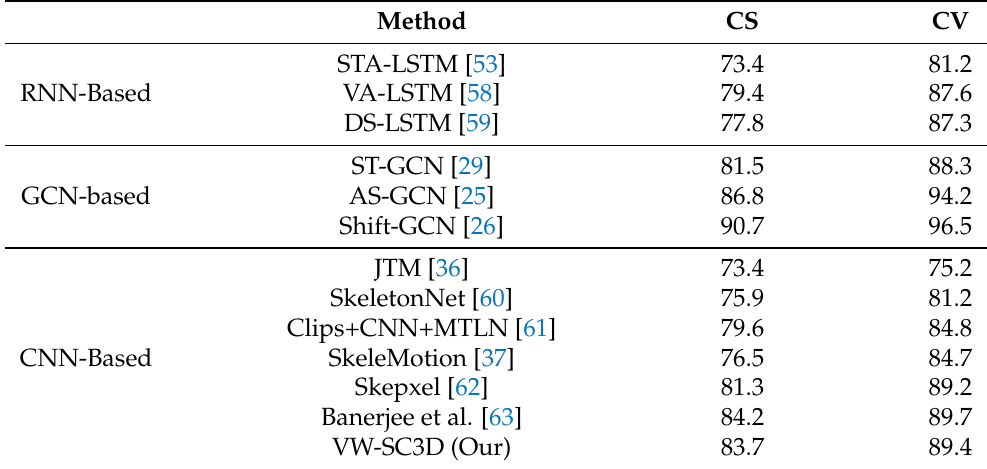
Table 4. Accuracy (%) comparisons with SOTA methods on NTU-RGB+D 60